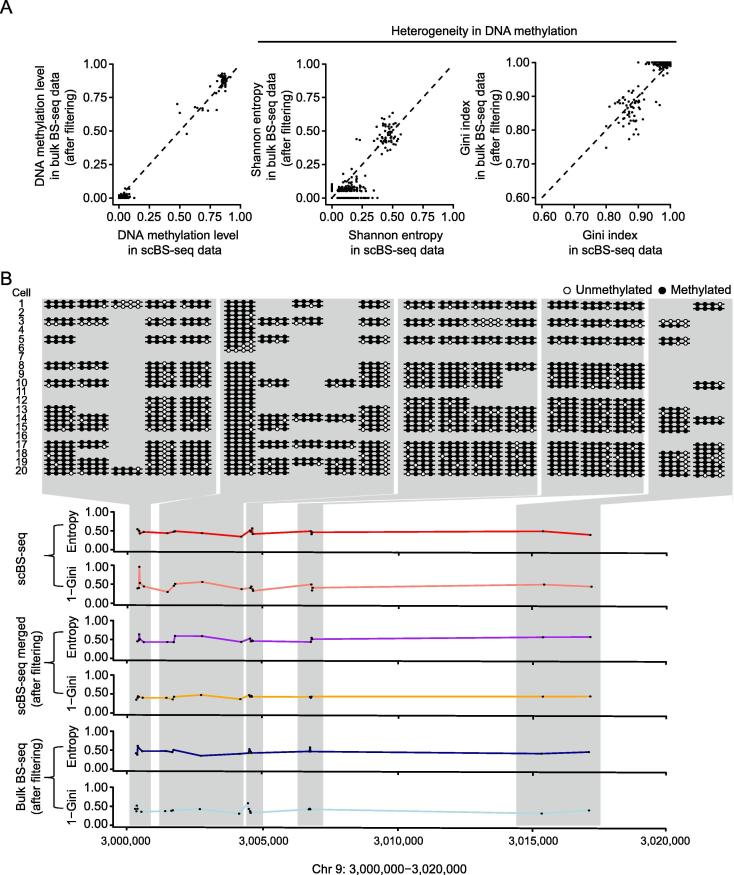
Reproducing the gold standard from the bulk BS-seq dataA. The gold standard can be faithfully reproduced from the corresponding filtered bulk BS-seq data. B. The landscape of heterogeneity in DNA methylation (Chr 9: 3,000,000–3,020,000) is largely reproduced from the filtered in silico merged scBS-seq and the filtered bulk BS-seq data.